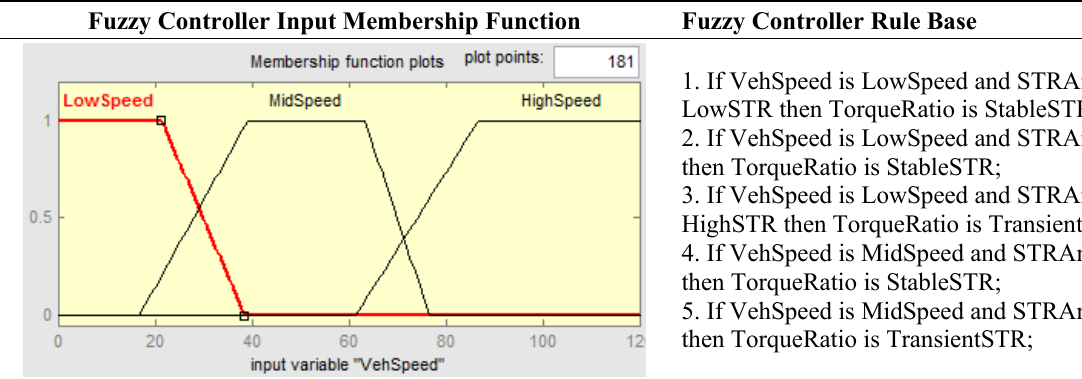
Table 5. Torque distribution strategy considering vehicle